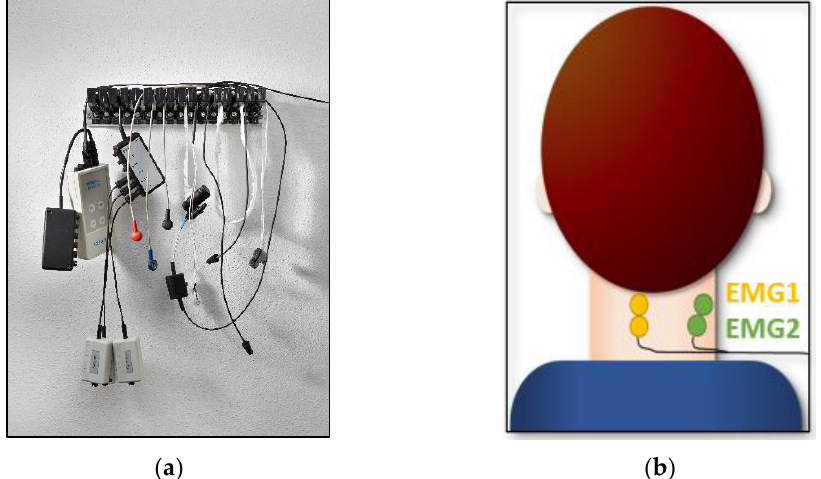
Figure 6. Illustration of the set up for the measurement of neck muscle tension: ( a ) Varioport with EMG electrodes; ( b ) Positioning of EMG electrodes on the posterior (EMG1) and lateral (EMG2) neck muscles.